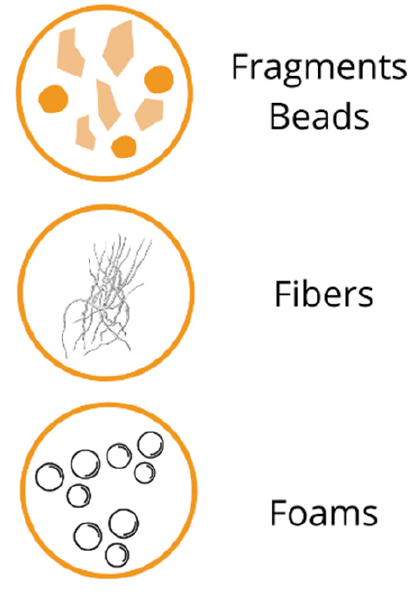
Figure 1. MPs morphology types [15].